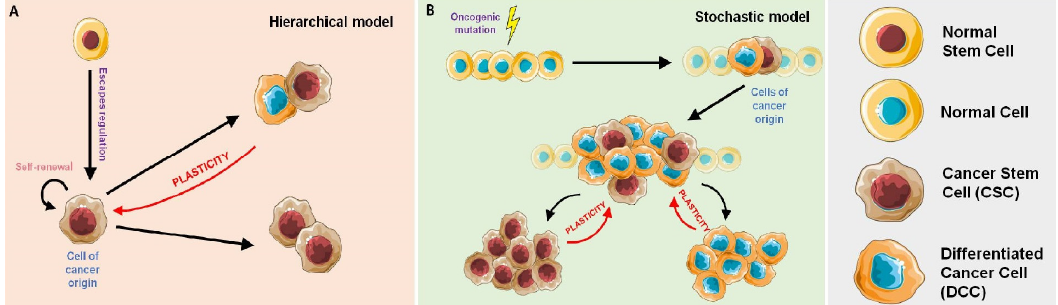
Figure 1. Tumor cell models . ( A ) Hierarchical model of division: a cancer stem cell (CSC) is originated from a normal stem cell that escapes from cell cycle regulation. This CSC has self-renewal capacity and acts as the cell of origin of the tumor and can generate different types of tumor cells. Because of plasticity, those differentiated cells can reverse their phenotype into CSCs. ( B ) Stochastic model of division: The cells of origin of the tumor can be any type of cell that experiences oncogenic mutations. Some mutations can lead to stem-like phenotypes and thus the cells become CSCs. This phenomenon (plasticity) unites the hierarchical model with the stochastic model.